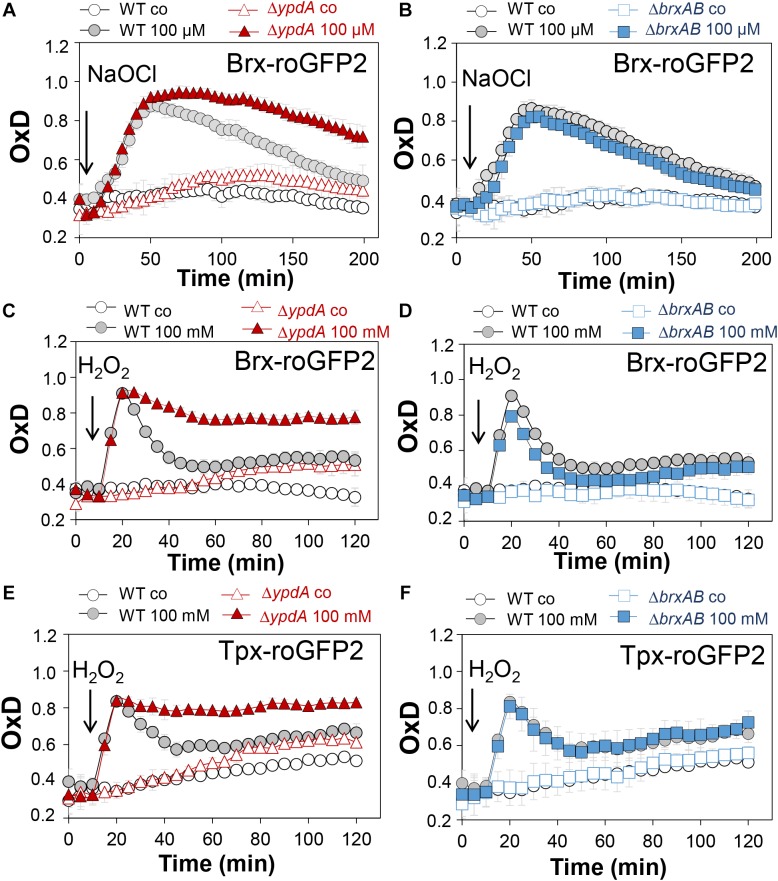
Brx-roGFP2 and Tpx-roGFP2 biosensors measurements of the OxD indicate that the S. aureusΔypdA mutant is impaired to regenerate the reduced state of EBSH and to detoxify H2O2 during recovery from oxidative stress. (A–D) Response of the Brx-roGFP2 biosensor to 100 μM NaOCl and 100 mM H2O2 stress in S. aureus COL WT, the ΔypdA
(A,C) and ΔbrxAB
(B,D) mutants. (E,F) Response of the Tpx-roGFP2 biosensor under 100 mM H2O2 stress in the S. aureus COL WT, the ΔypdA and ΔbrxAB mutants. The Brx-roGFP2 biosensor responses are shown as OxD values and the corresponding EBSH changes were calculated using the Nernst equation and presented in Supplementary Figure S5 and Supplementary Tables S5, S6. Mean values and SD of three biological replicates are shown.